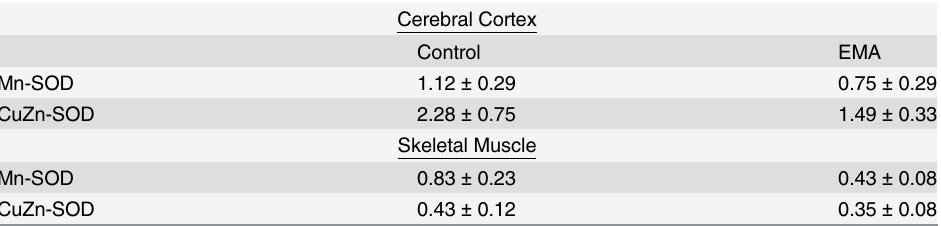
Table 1. Effect of acute administration of ethylmalonic acid (EMA) on Mn-SOD and CuZn-SOD activi- ties in cerebral cortex and skeletal muscle of rats.